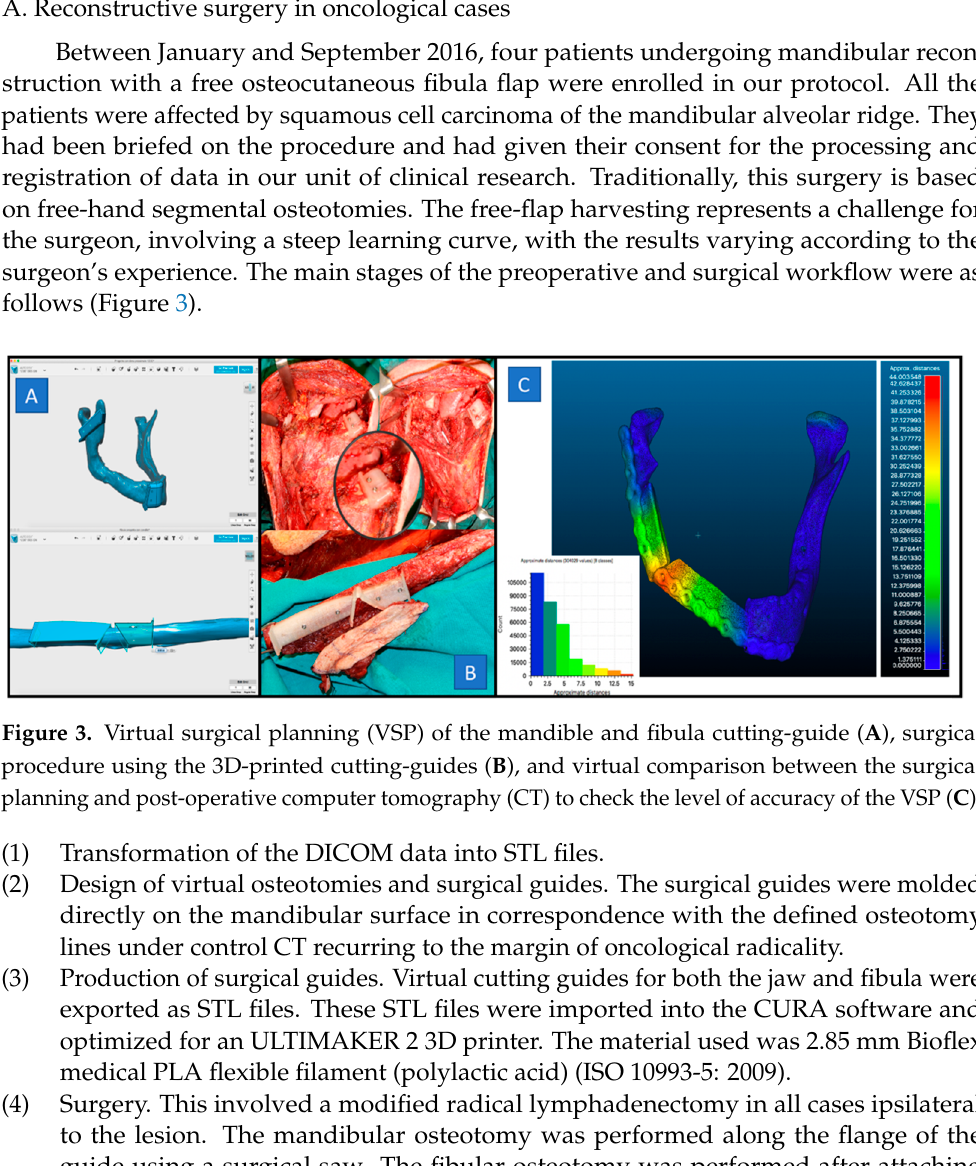
Figure 2. Digital workflow of our study showing in detail every application necessary for the 3D print process (every application is completely open source).